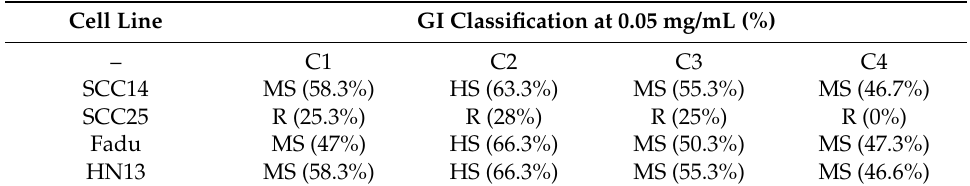
Table 3. Growth inhibition to different fractions of the T. guianensis extract in HSCC cell lines.